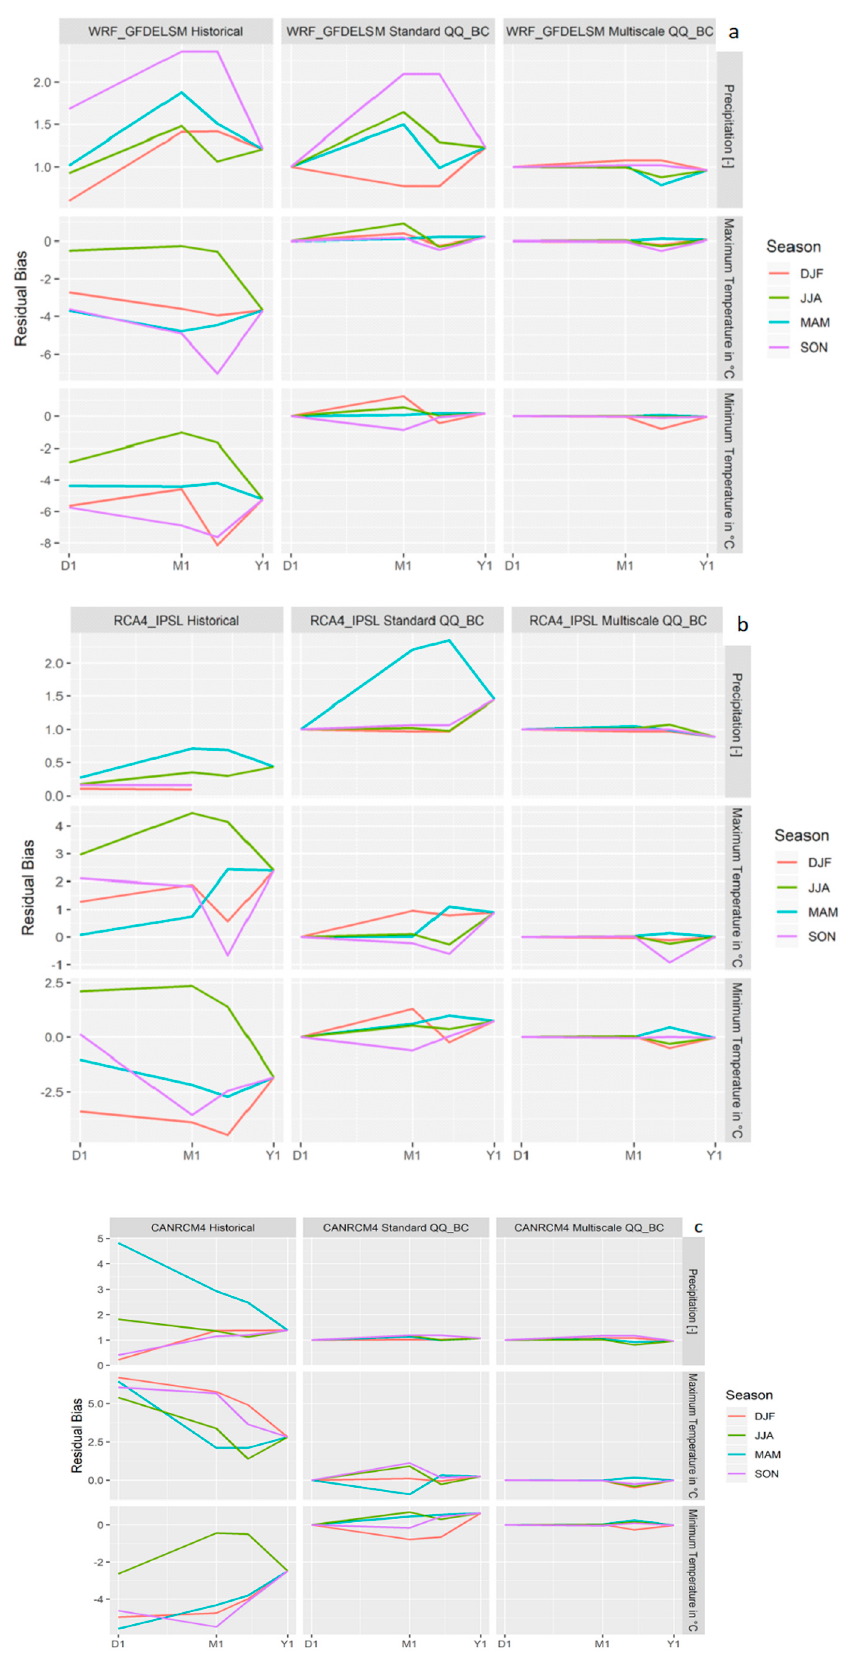
Figure 4. Standard quantile mapping and multiscale bias correction for the three RCMs: ( a ) WRF, ( b ) RCA4, and ( c ) CANRCM4.